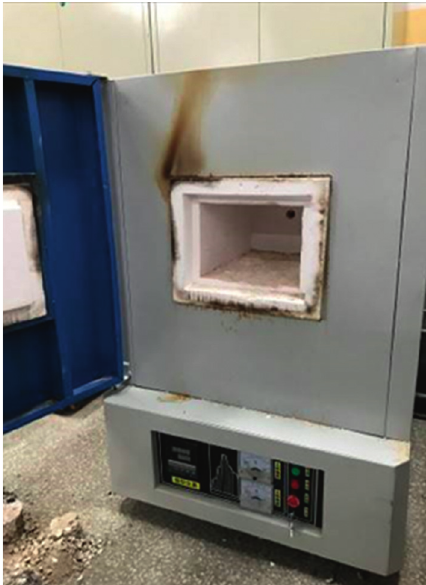
Figure 4: XH7L chamber-type electric resistance